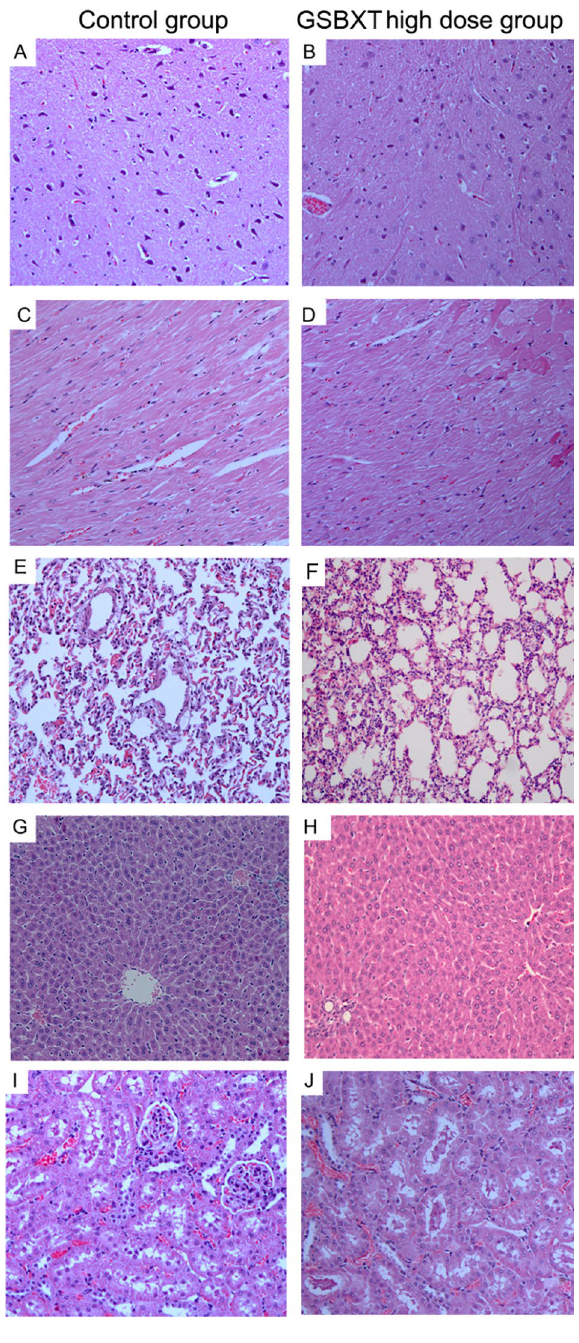
Figure 2. The corrected version of Figure